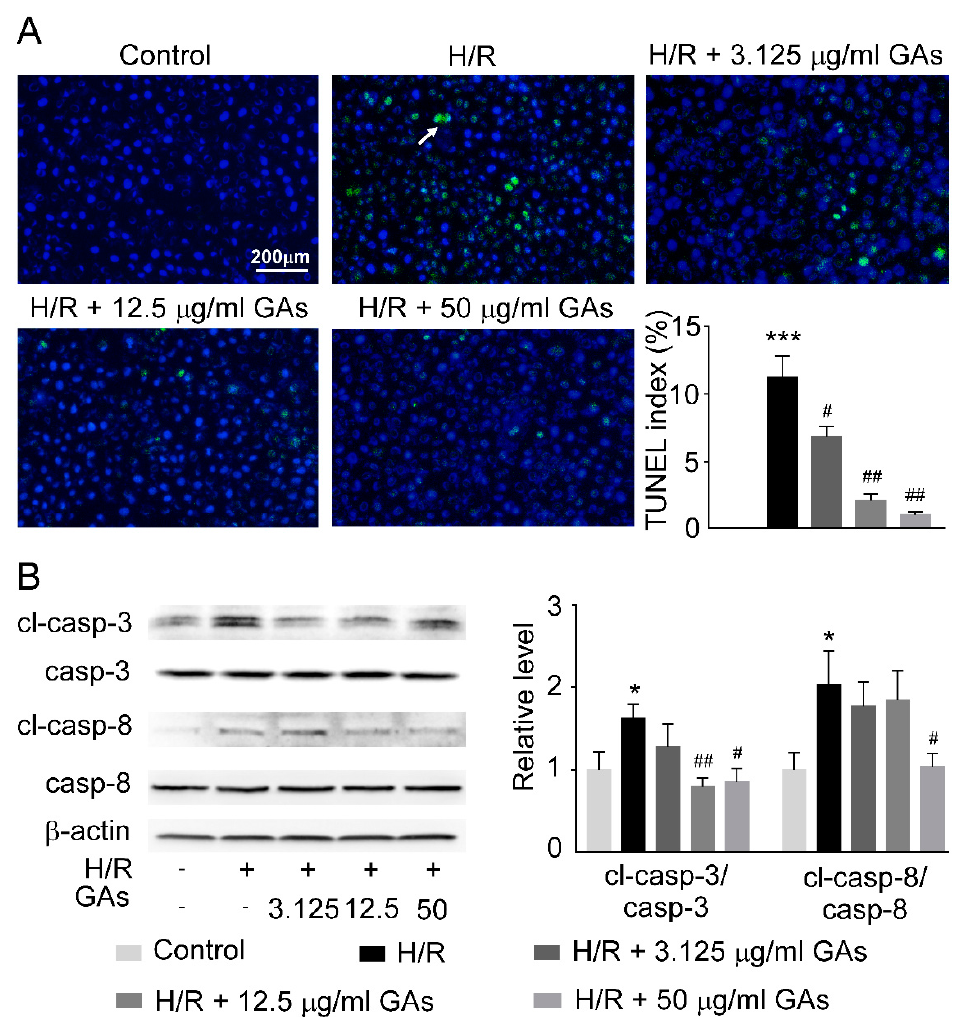
Figure 6. GAs suppressed the activation of apoptosis in response to H/R in NRK-52E cell. ( A ) Rep- resentative TUNEL staining (magnification 200×) and the quantification of TUNEL-positive index ( n = 8). ( B ) Representative Western blots and the relative protein levels of key enzymes involved in apoptosis in NRK-52E cell. The data of target proteins are expressed relative to the intensity of the Control group. Values are expressed as the mean ± SEM ( n = 5~6). * p < 0.05 and *** p < 0.001 com- pared with Control group; # p < 0.05 and ## p < 0.01 compared with H/R group (two-tailed Student’s t -test or one-way ANOVA).